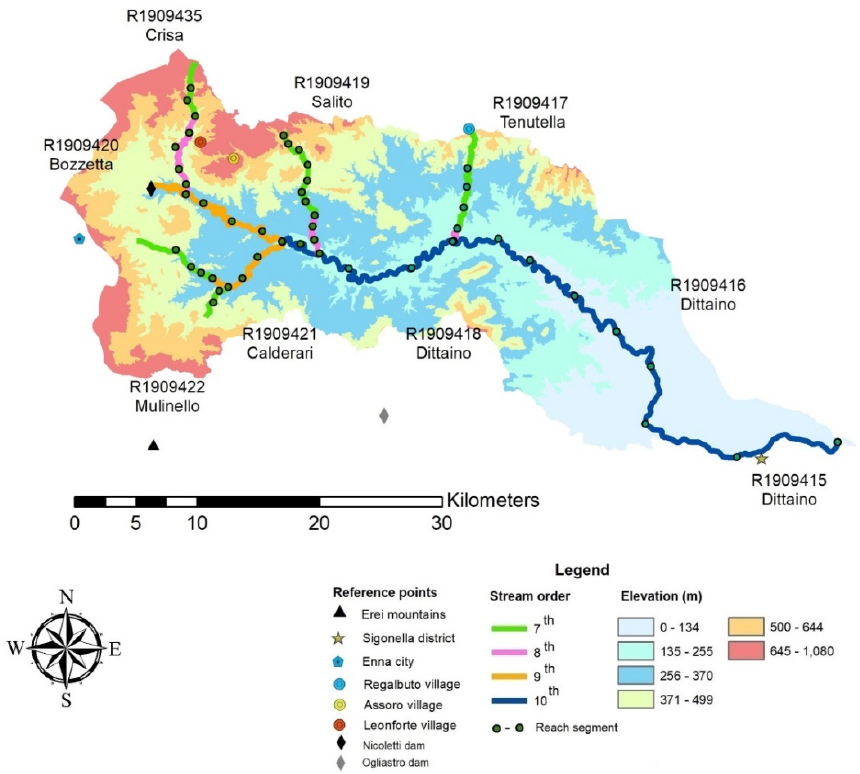
Figure 3. Map of the Dittaino River basin, with stream order and elevation.